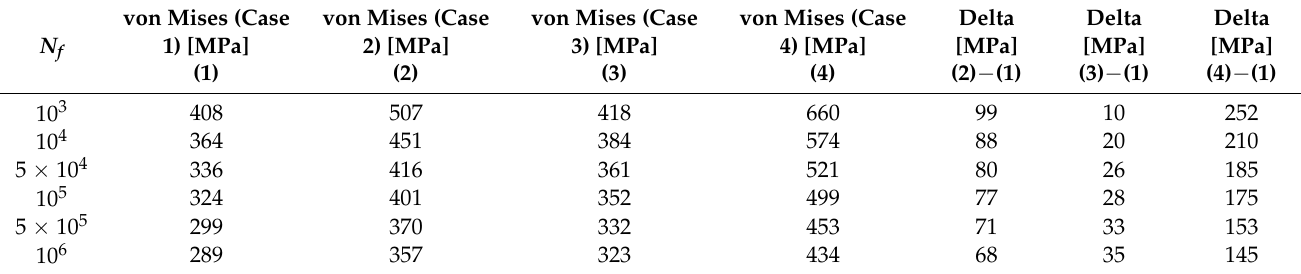
Table 8. Correlation between loading paths regarding von Mises stress levels —AISI303.